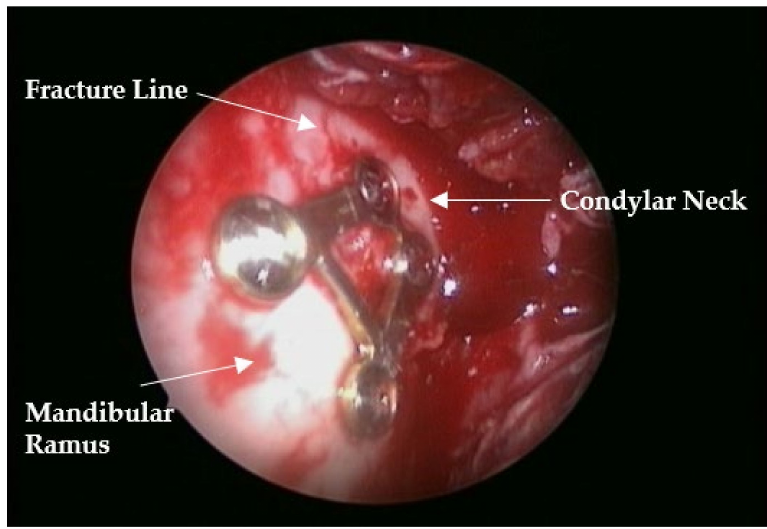
Figure 2. Endoscopic view of the trapezium plate after condylar fracture fixation.